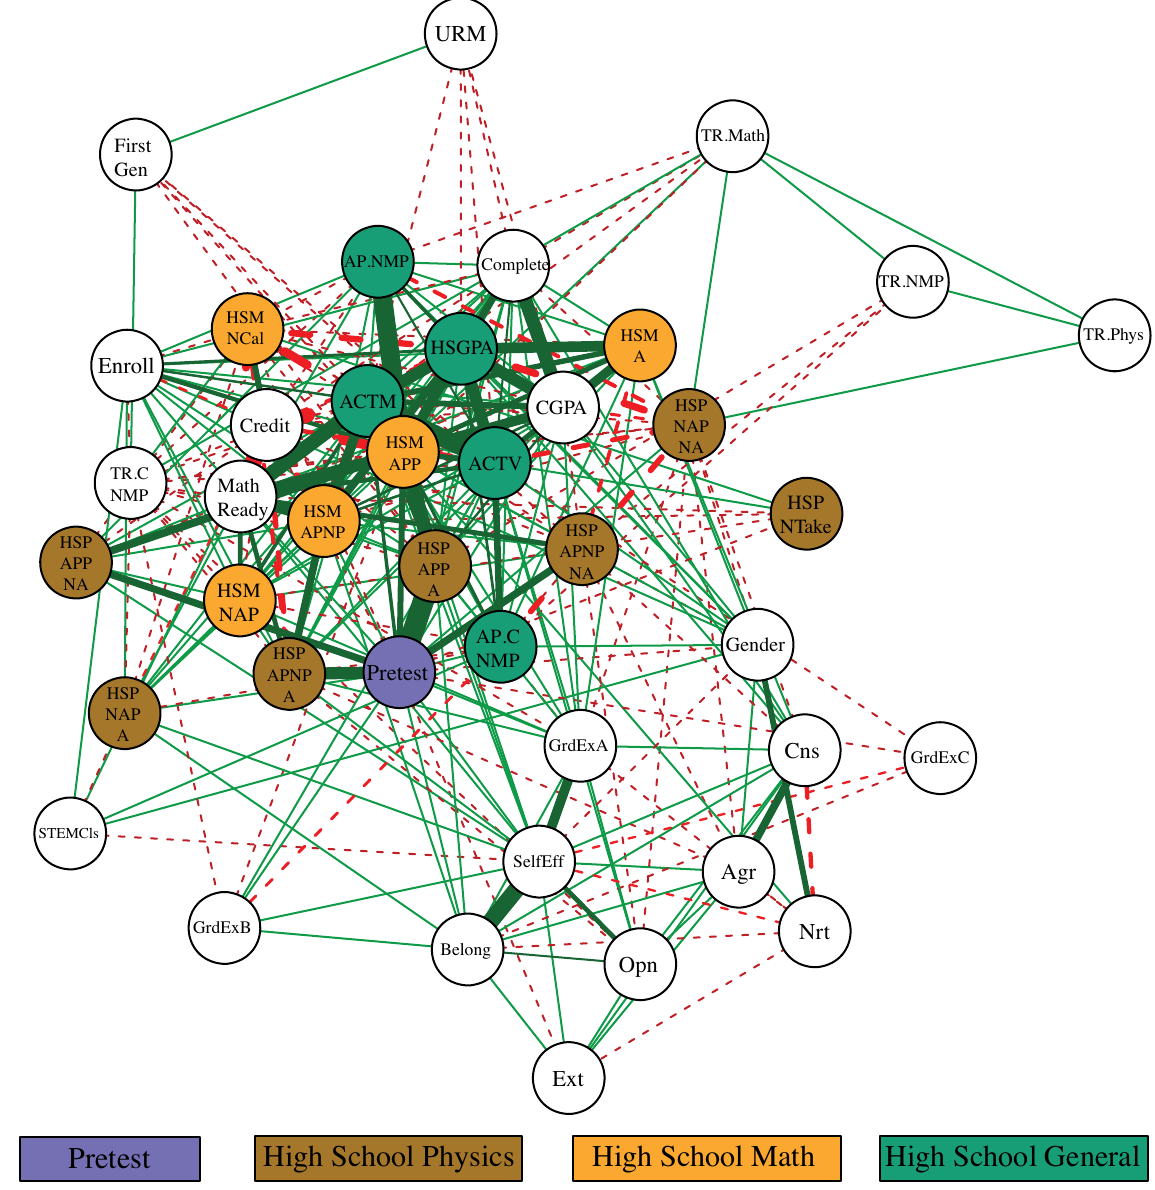
FIG. 1. Correlation matrix. Green (solid) lines represent positive correlations; red (dashed) lines negative correlations. Thicker lines represented stronger